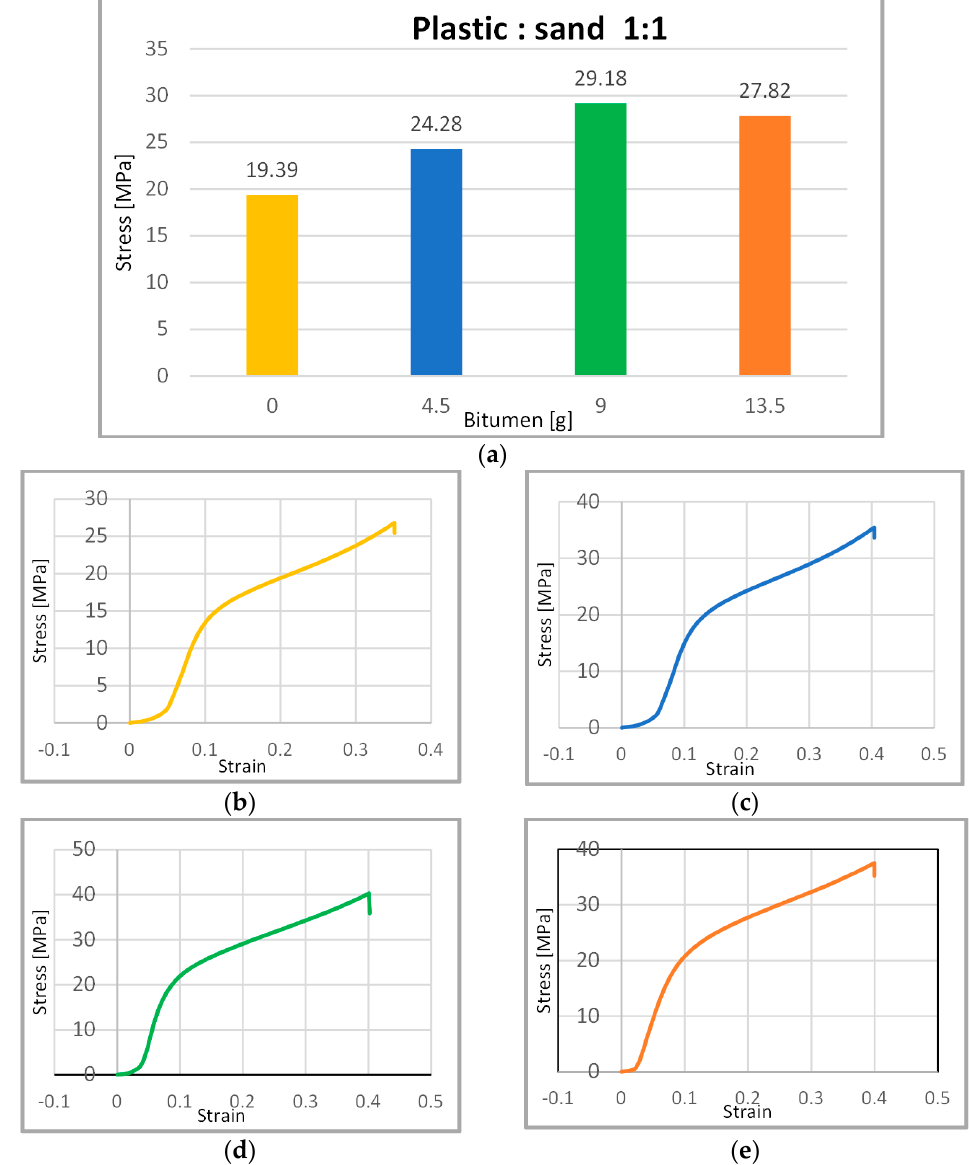
Figure 4. Results of brick sample 3. ( a ) Compression strength values of brick plastic to sand 1:1. ( b ) Stress–strain curve with 0 g bitumen. ( c ) Stress–strain curve with 4.5 g bitumen. ( d ) Stress–strain curve with 9 g bitumen. ( e ) Stress–strain curve with 13.5 g bitumen.